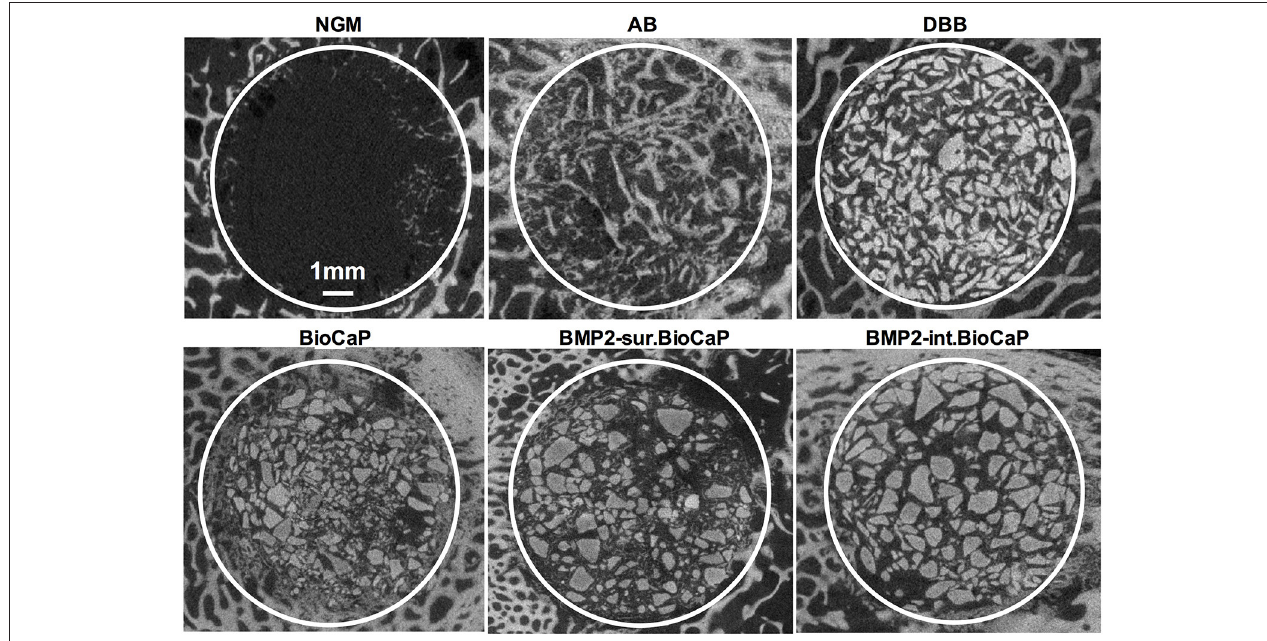
FIGURE 3 | Micro-CT images showing newly formed bone and grafted biomaterials in the defect site after 4 weeks of grafting.